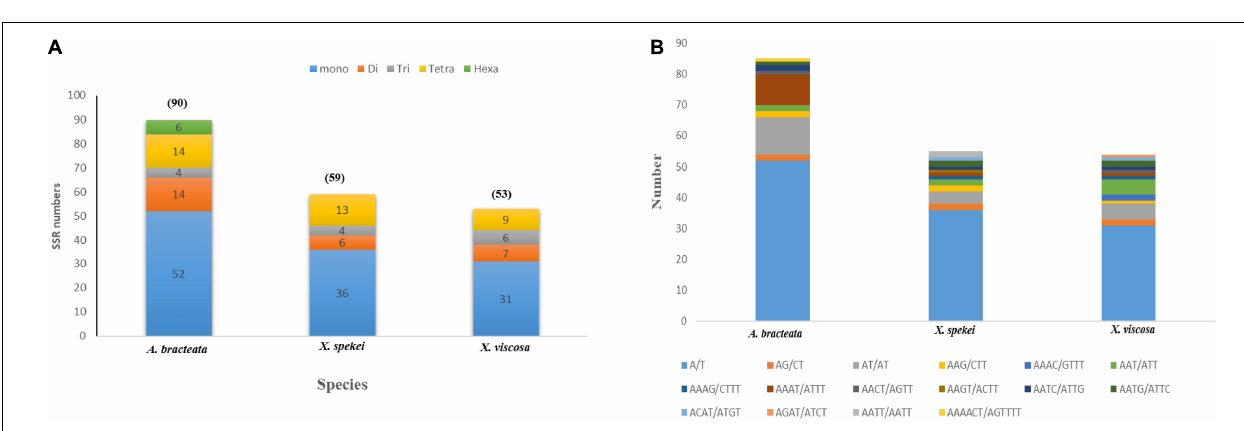
choice of codons within the plastome can be used to show gene expressions and speciation mechanisms in